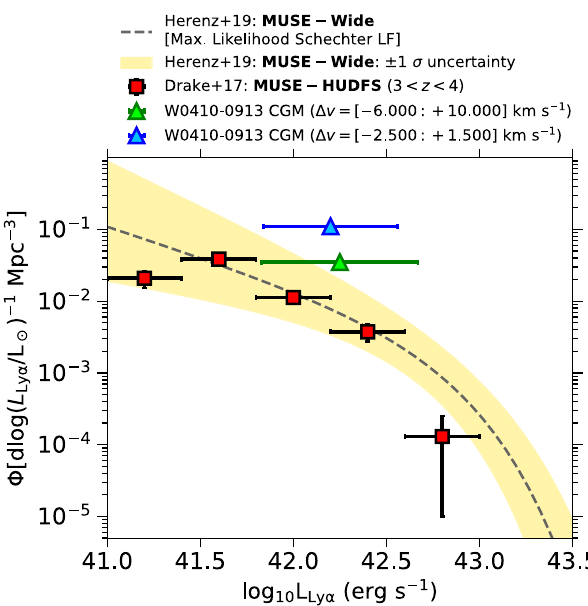
Fig. 2 | The Hot DOG W0410-0913 evolves in an very dense environment. We quantify the signi fi cance of the overdensity of companion galaxies discovered aroundW0410-0913,bothinthewholevolumede fi nedbytheoffsetvelocityrange [ − 6.000; +10.000]kms − 1 (green triangle) and in the denser volume de fi ned by the offset velocity range [ − 2.500; +1.500]kms − 1 (blue triangle). We compare their Lyman- α luminosity-weighted number densities with the expected values for fi eld galaxies at comparable redshift according to the Lyman- α luminosity functions measured with MUSE in wide 27 (gray line and yellow shaded region, representing the ±1 σ uncertainty on the fi tting parameters) and deep 26 surveys (red points and black lines, representing the ±1 σ errors). The number density of Lyman- α -emitting galaxies, n LyE , associated with W0410-0913 is a factor of about 14 higher than the value(<n LyE >)expectedfor fi eldgalaxieswithcomparableLyman- α luminosity.The green and blue error bars represent the range of Lyman- α luminosities covered by companion galaxies in the whole and denser volume,